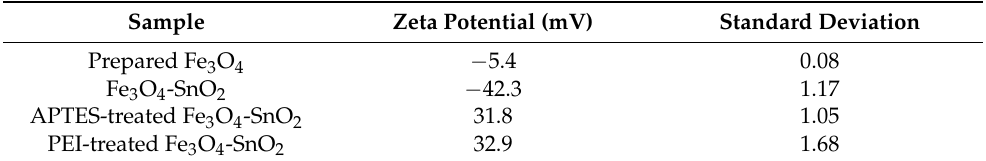
Table 1. Zeta potentials of the as-prepared Fe 3 O 4 , Fe 3 O 4 -SnO 2 , APTES-treated Fe 3 O 4 -SnO 2 ,